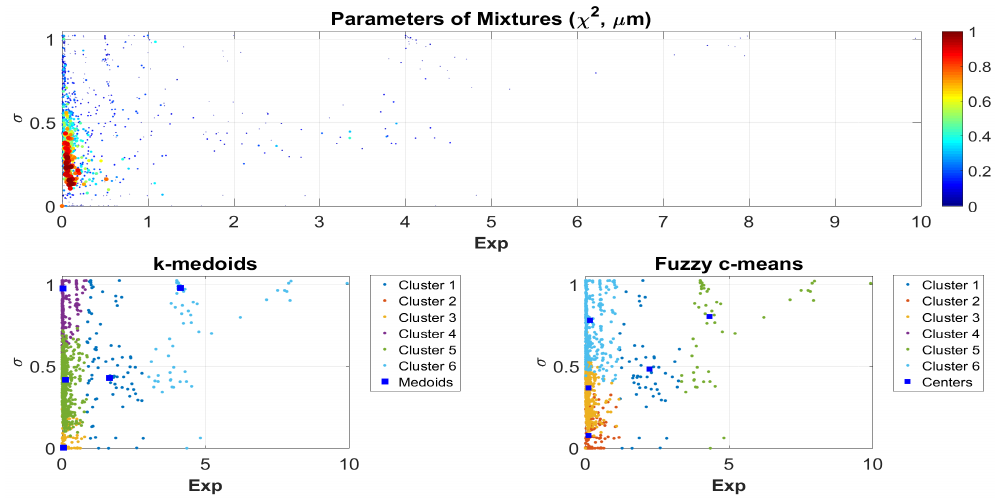
Figure A24. Clustering the mixture parameters (minimizing χ 2 estimates, µ